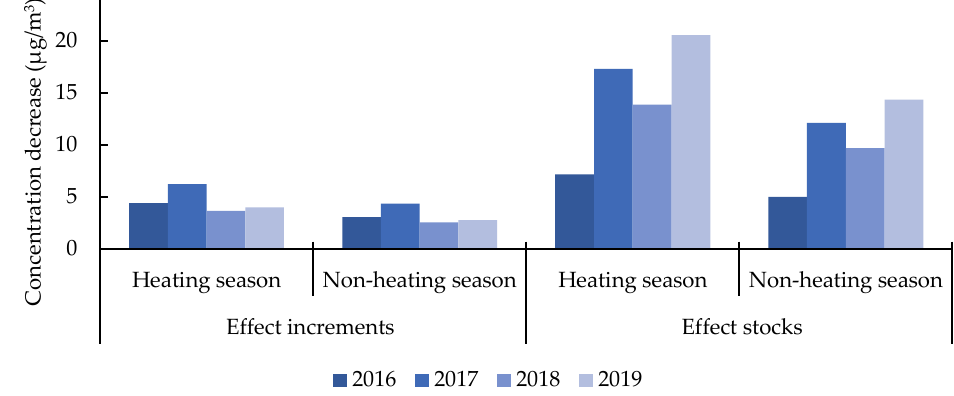
Figure 4. The decrease of PM 2.5 concentration driven by NEV promotion in Beijing from 2016 to 2019. As the quota for NEVs in Beijing from 2016 to 2019 remained unchanged, the effect of increments of the PM 2.5 concentration reduction caused by NEV promotion in Beijing had not changed significantly. The average annual concentration reduction increments were between 3.23 µ g/m 3 and 4.61 µ g/m 3 . As for the effect stocks, there was a significant decline between 2017 and 2018 although the ownership of NEVs in Beijing kept growing during this period; see Figure 1. One of the reasons is that emission factors of PM 2.5 and NO x continued to decline with the development of mitigation technologies. The other and more important reason is the apparent decline in travel distance from 2017 to 2018; see Figure 2. In 2019, the concentration reduction effect reached 14.40 µ g/m 3 to 20.57 µ g/m 3 , accounting for 34.29% to 48.98% of Beijing’s annual average PM 2.5 concentration (42 µ g/m 3 ) at the same period. This result shows the significant PM 2.5 emission reduction effects of promoting